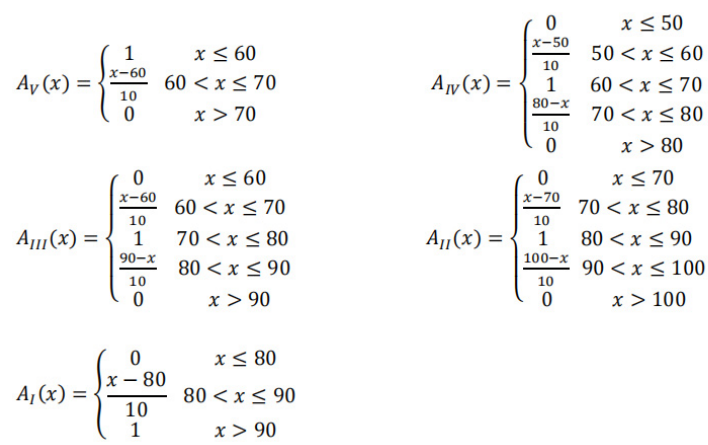
Figure 4. Fuzzy comprehensive evaluation membership